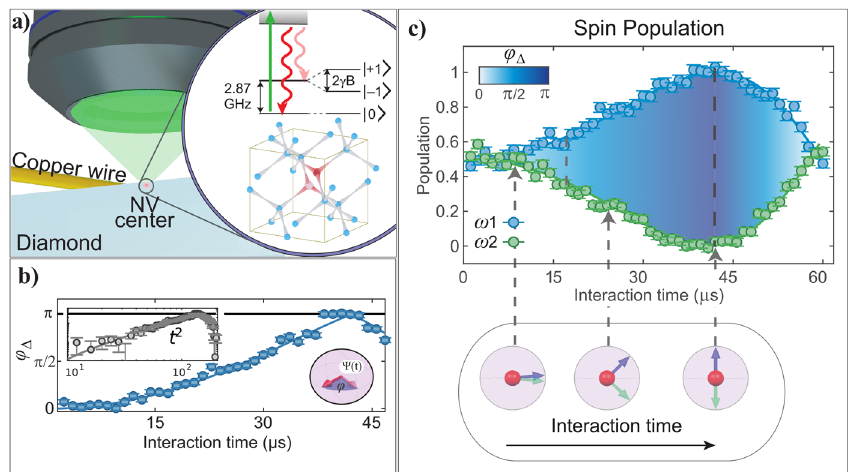
Fig. 2 Quantum-frequency discrimination. a Experimental setup: the spin state of a single nitrogen-vacancy (NV) center in diamond responds to magnetic fi elds by a Zeeman shift of the spin levels, which can be optically initialized and readout with a confocal microscope. b Experimentally measured quantum phase difference φ Δ as a function of coherent interaction time and as log – log plot (inset). Solid lines are a fi t to φ Δ ¼ 2 π B ω Δ t 2 , where ω Δ ¼ j ω 1 (cid:3) ω 2 j ¼ 2 π ð Þ (cid:7) 2 kHz. c Measured spin population as a function of coherent interaction time. The (cid:3) 1 sin B ω Δ t 2 π probability to be in state 0 j i is: P 0 j i ω 1 jð Þ ¼ 1 2 2